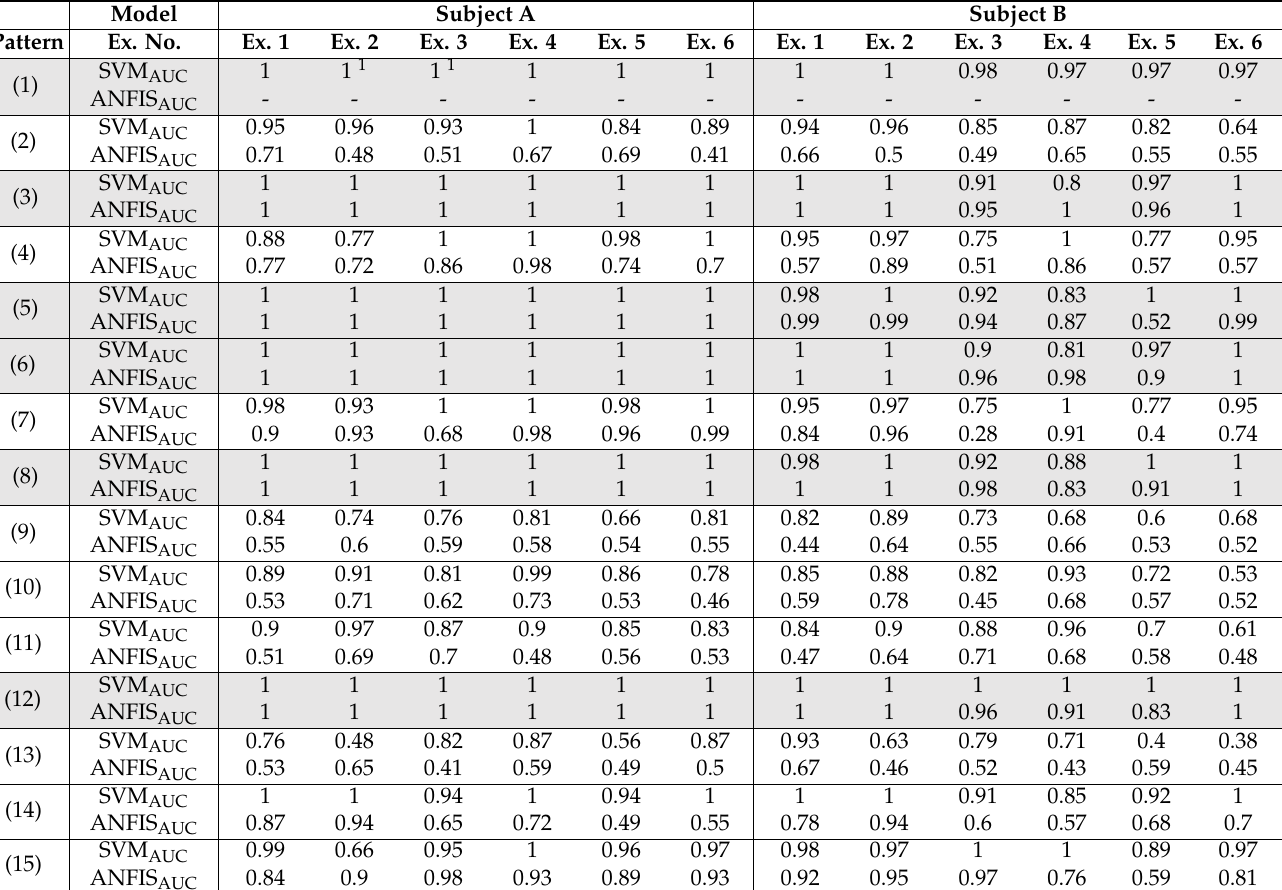
Table A1. Recognition AUCs of the proposed patterns and models for the subjects’ six exercises.